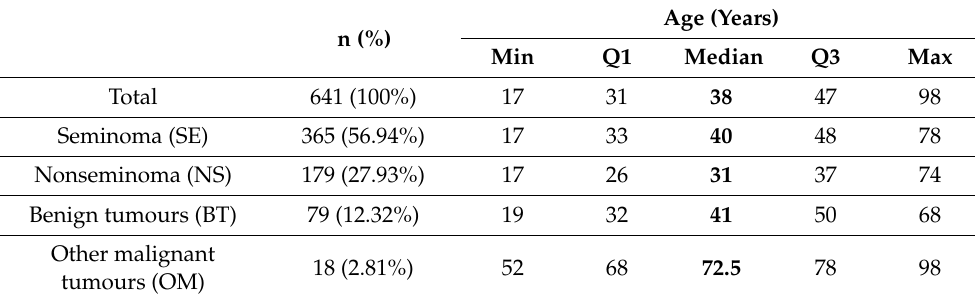
Table 1. Total patient population and frequency distribution of histologic subgroups and correspond- ing age distributions.